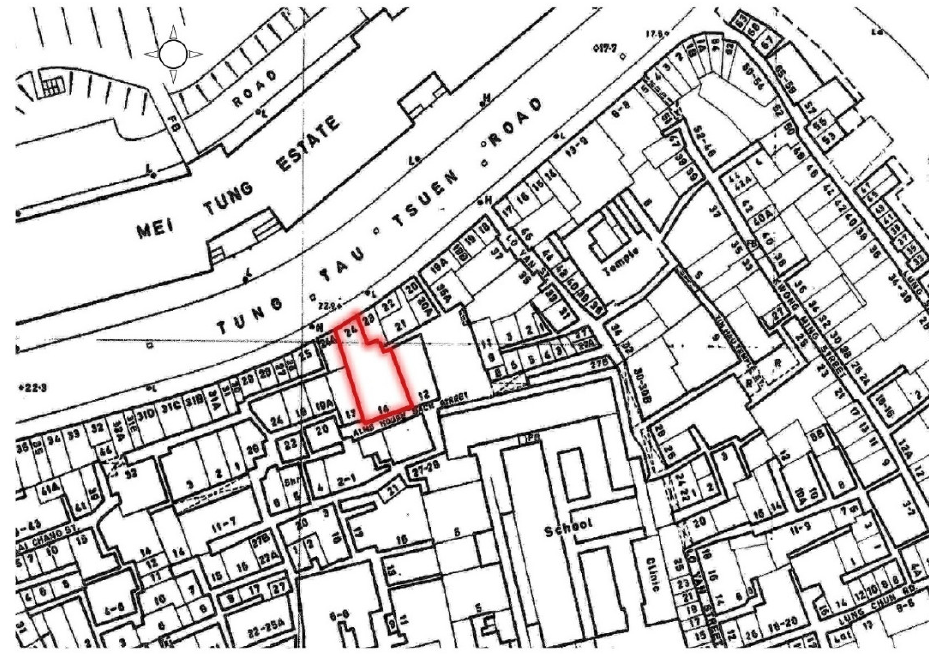
Figure 6. Images of No. 24 Tau Tung Road in 1961 ( above ) and after the redevelopment in 1977 ( below